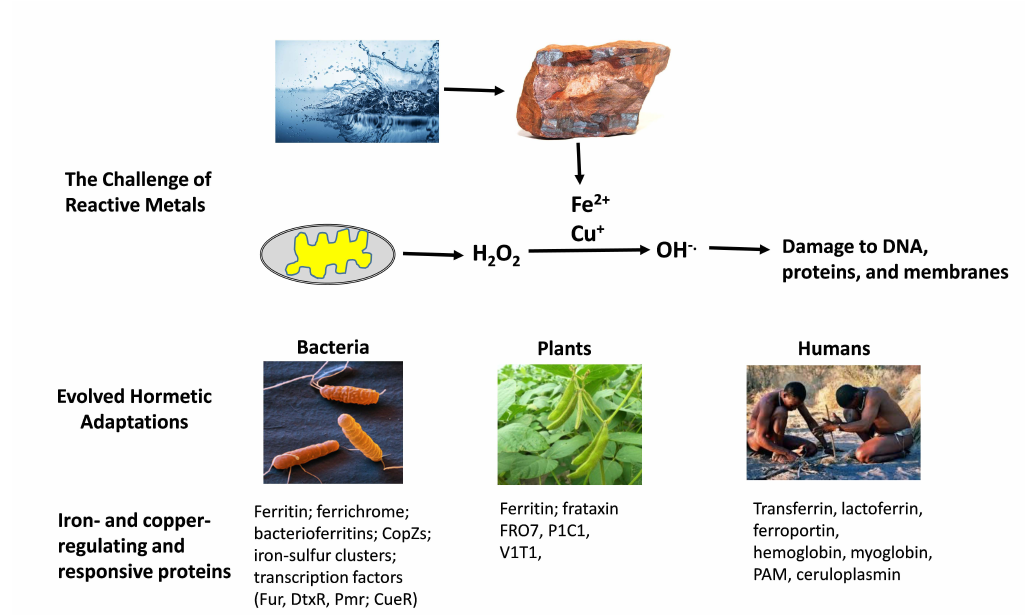
Fig. 1 Evolutionary hormesis-based adaptations that enabled organisms to survive and fl ourish in the presence of toxic metals. The solubilization of iron and copper in rocks results in the formation of ions (Fe 2+ and Cu + ) that can be highly toxic to cells. During respiration (oxidative phosphorylation), cells generate hydrogen peroxide (H 2 O 2 ). Interaction of H 2 O 2 with Fe 2+ or Cu + results in the generation of the highly destructive hydroxyl free radical (OH − . ), which can kill cells by damaging DNA, proteins, and membrane lipids. Beginning very early